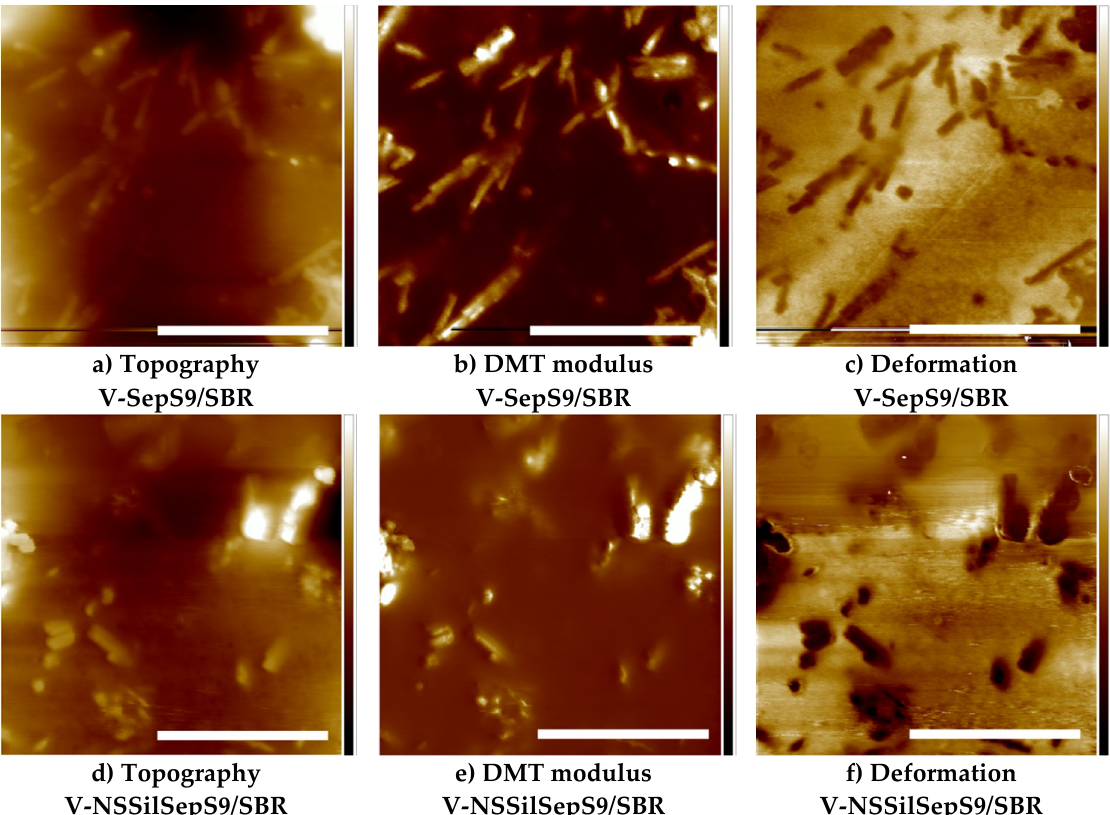
Figure 9. Peak force tapping images of V-SepS9/SBR and V-NS-SilSepS9/SBR. ( a ) and ( d ) topography, ( b ) and ( e ) Derjaguin, Muller, Toropov (DMT) modulus, and ( c ) and ( f ) deformation. Brighter colors indicate higher values of ( a ) surface height, ( b ) modulus, and ( c ) deformation. The white scale bar is 1.0 μm. The Z-range is 100 nm, the DMT range is 2.0 GPa, and the deformation range scale is 5 nm.